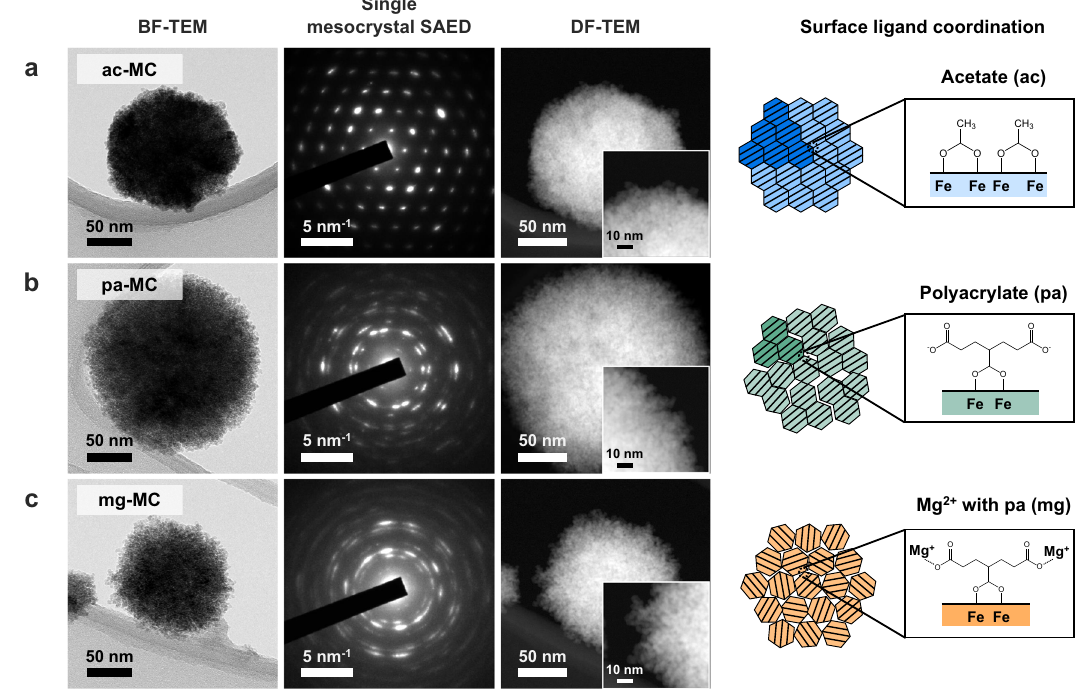
Fig. 3 Disorder – order transition in the crystallographic alignment in mesocrystals during OA. a – c Morphological and microstructural analyses of Fe 3 O 4 mesocrystals with different crystallographic orders in BNC tiling depending on the surface ligand: acetate (ac) ( a ), polyacrylate (pa) ( b ), and Mg 2 + - adsorbed polyacrylate (mg) ( c ). Bright- fi eld (BF)-TEM images display a representative shape for each mesocrystal, and the SAED pattern was acquired from the single mesocrystal in the TEM images. Dark- fi eld (DF)-STEM images describe the change in the outline of single mesocrystals.